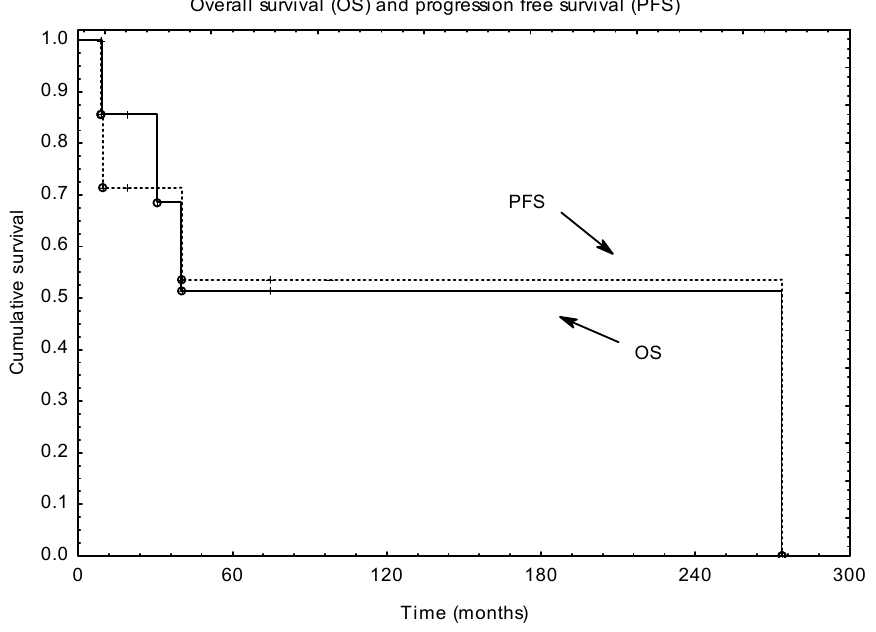
Figure 1. Overall and progression-free